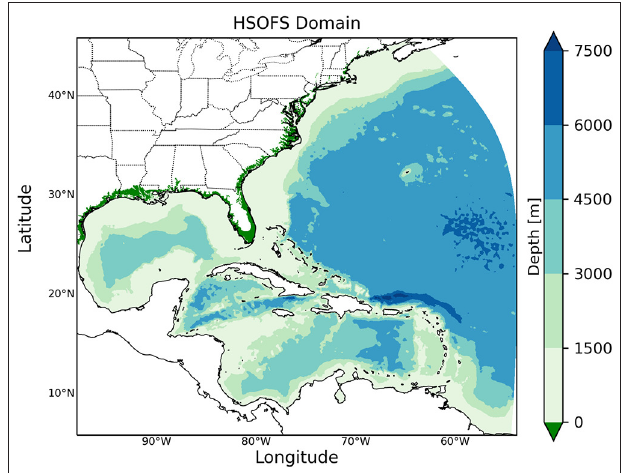
FIGURE 2 | Computational domain (colored regions) and bathymetry of the Advanced Circulation (ADCIRC) model, the Hurricane Surge On-demand Forecast System (HSOFS) mesh. Bathymetry is shown in meters below mean sea level. Dark green regions are used to depict areas that are above sea level, i.e.,